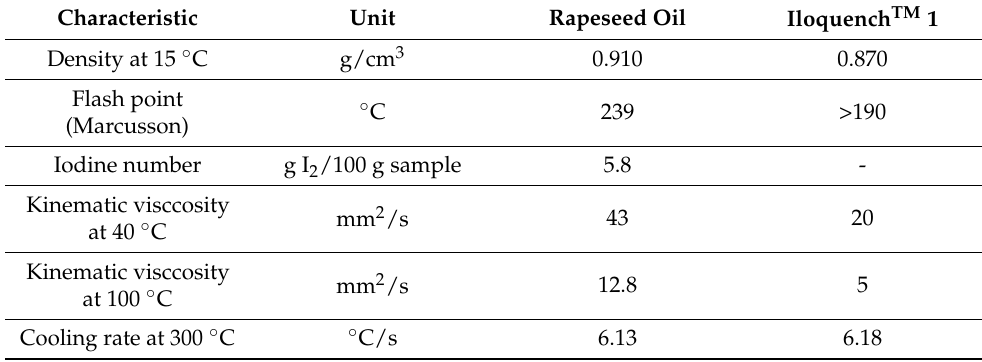
Table 1. The characteristics of the waste rapeseed oil in comparison with the mineral oil. Characteristic Unit Rapeseed Oil Iloquench TM 1 Density at 15 ◦ C g/cm 3 0.910 0.870 Flash point (Marcusson) Kinematic visccosity at 40 ◦